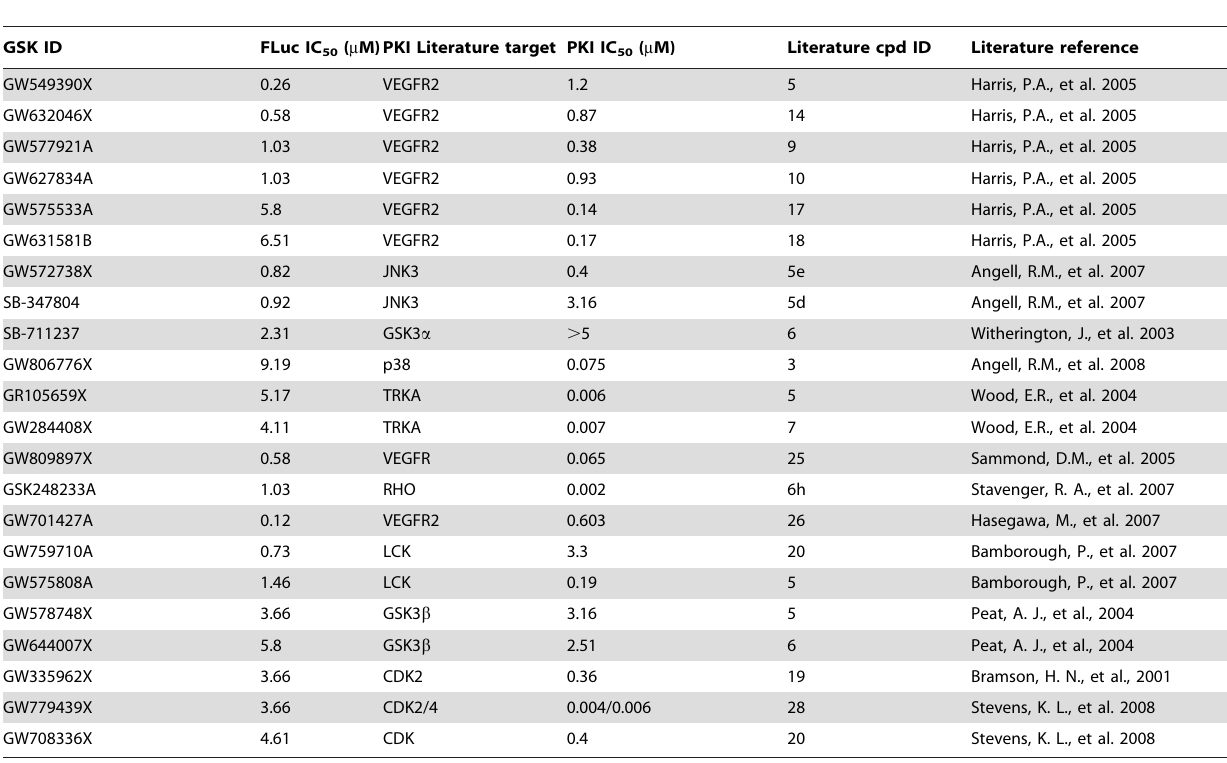
Table 3. Comparison of FLuc activity to PKI literature target